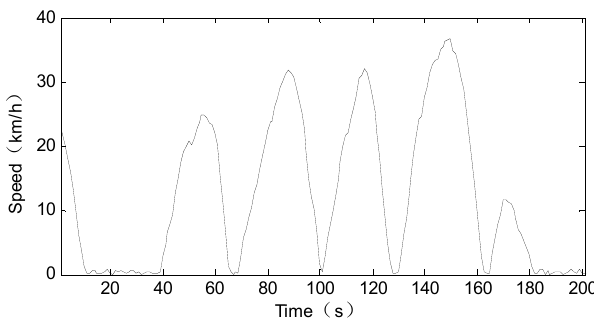
Figure 6. The speed segment of United Kingdom Bus (UKBUS) driving cycle.